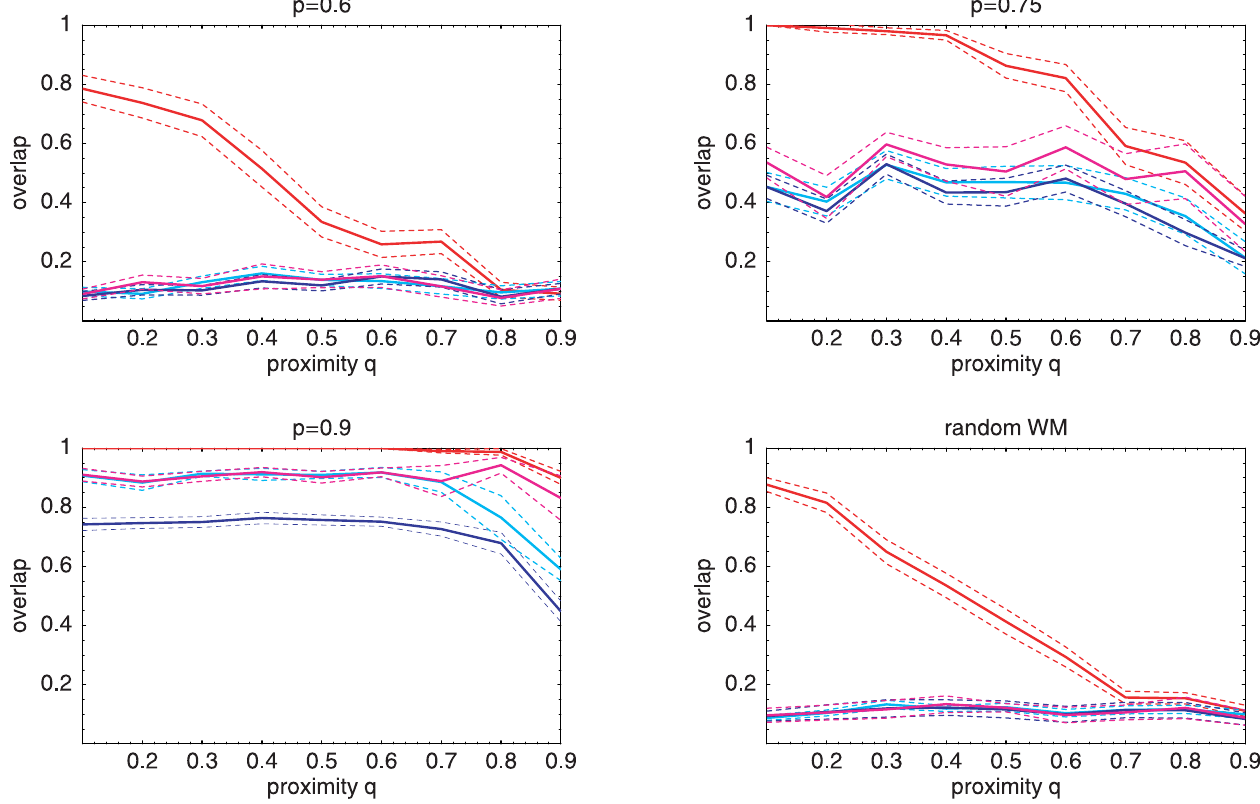
Figure 3. Performance of PhyloGibbs and Non-Phylo Motif-Finding Algorithms on Alignments of Orthologous Intergenic Regions as a Function of the Evolutionary Proximity of the Orthologs and the Quality of the WM PhyloGibbs with phylogeny (red), PhyloGibbs in non-phylo mode (light blue), WGibbs (dark blue), and MEME (pink) were run on alignments of S ¼ 5 intergenic regions of length L ¼ 500, each at a proximity q to the common ancestor and each containing s ¼ 4 binding sites from a single WM of width w ¼ 10. In the upper left panel, WMs had polarization p ¼ 0.6, in the upper right p ¼ 0.75, in the lower left p ¼ 0.9, and in the lower right random WMs (drawn uniformly from the simplex) were used. The solid lines show the average overlaps between the predicted sites and the real sites, and the dotted lines show two standard errors (estimated from 50 different datasets generated with equal parameters for each data point). DOI: 10.1371/journal.pcbi.0010067.g003 PLoS Computational Biology |